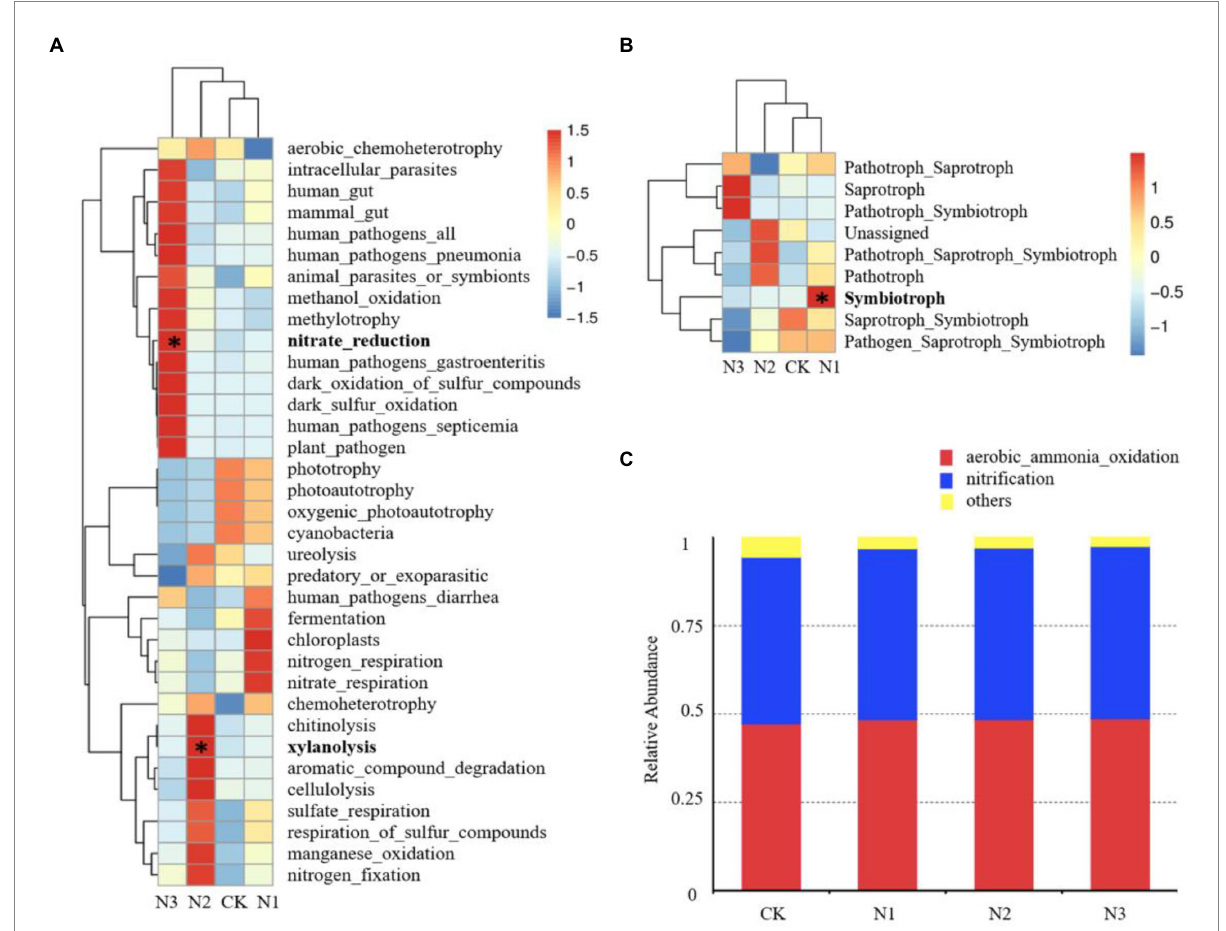
FIGURE 5 Effect of N addition on microbial community functions. (A) Effect of N addition on the relative abundance of the top 35 bacterial community functions. (B) Effect of N addition on the relative abundance of fungal community functions. (C) Effect of N addition on the relative abundance of archaeal community functions. * Indicates p <